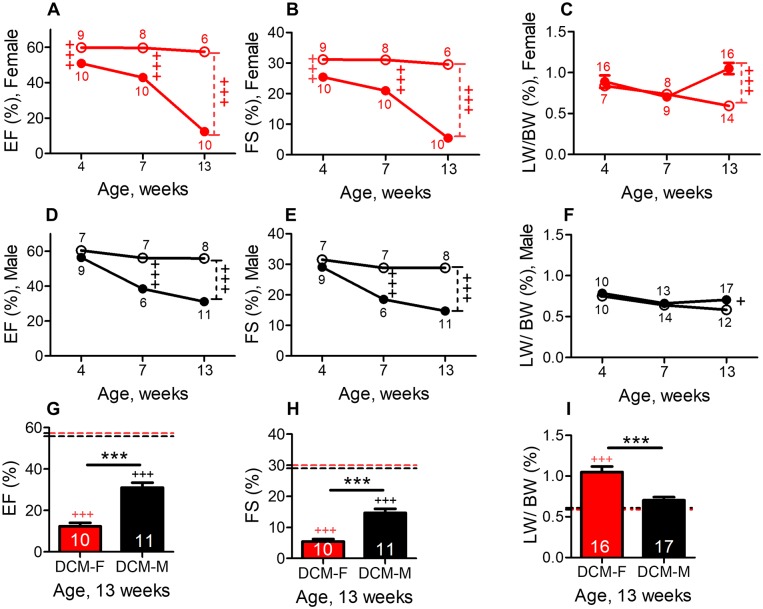
Female mice with DCM show accelerated declines in systolic function and increased lung water retention when compared with male mice with DCM.Age- related changes in ejection fraction (EF%) in female (A) and in male mice(D) fractional shortening (FS%) in female (B) and in male mice (E) LW/BW% in female (C) and in male (F) mice with and without DCM. Figs 1D, 1E and 1F were reproduced from our previously published data [19]. Female or male with DCM are indicated by closed symbols, female or male without DCM by open symbols. The number of animals per group at each time point is shown. Age dependent changes in both sexes were analyzed by two-way ANOVA. At 13 weeks of age, changes in EF% (G) FS% (H) and LW/BW% (I) in female and male mice with or without DCM. DCM-F (DCM female, red), DCM-M (DCM male, black), dotted red (female) and black (male) line represent mean baseline levels in mice without DCM. The number of DCM mice is indicated. Differences among groups at 13 weeks were analyzed by one-way ANOVA. ***P<0.001 (DCM female vs DCM male). +++P<0.001, and +P<0.05 (DCM vs. WT mice).